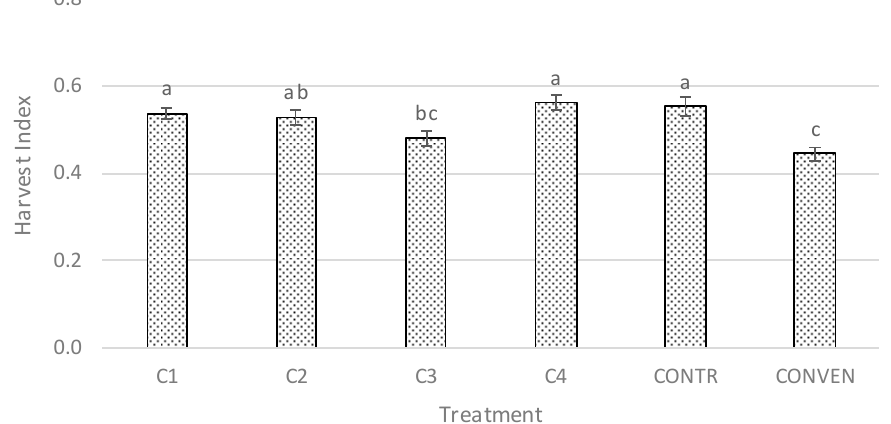
Figure 9. Harvest index (HI) (means ± se) of rice plants grown in di ff erently fertilized soil of the experiments during 2017 and 2018. Treatments contain compost application of (i) 80 kg ha − 1 N in split application (C1), (ii) 160 kg ha − 1 N in split application (C2), (iii) 320 kg ha − 1 N in split application (C3), (iv) 160 kg ha − 1 N in single application (C4), (v) an untreated control (CONTR), and (vi) 160 kg ha − 1 nitrogen chemical fertilizer (CONVEN). Means were compared by the Bonferroni adjusted LSD value at p < 0.05. Di ff erent letters characterize significant di ff erences between treatments. Full description of the treatments examined is given in Table 3.